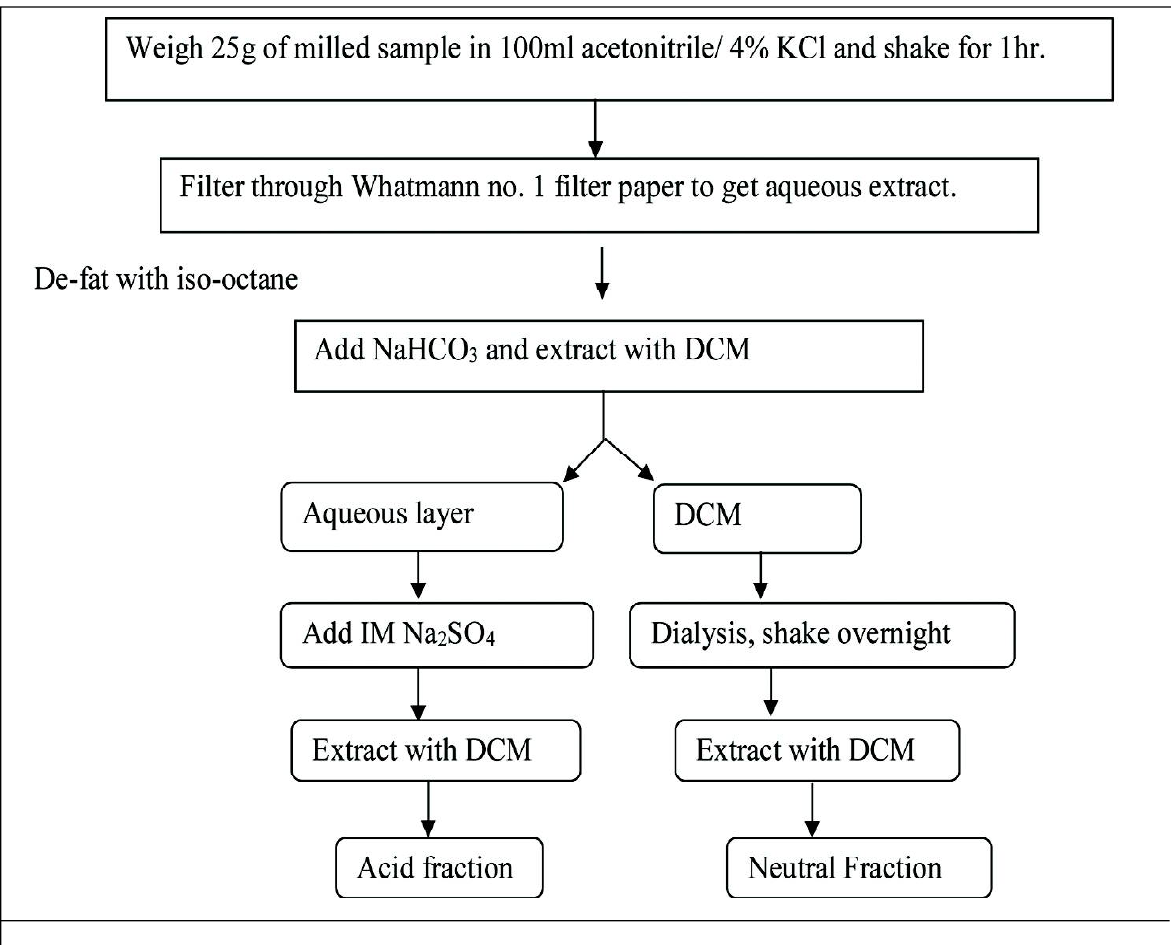
Figure 2: Multi-mycotoxin